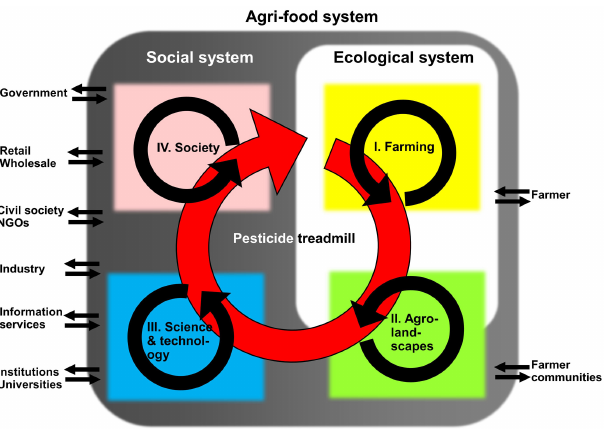
agro-landscapes (green), (III) science and technology (blue), and (IV) society (pink). Each domain contains internal positive feedbacks (black cycles), but also interacts externally with other mechanisms and drivers of the pesticide treadmill (red cycle), enforcing the lock-in situation of pesticide use. Each domain is embedded in either the social (grey) or ecological system (white), except for agro-landscapes, which is linked to both. Influential actors are depicted on the sides and interactions with the agri-food system are indicated by black arrows. Actors